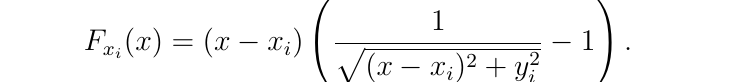
= 1 and different y i